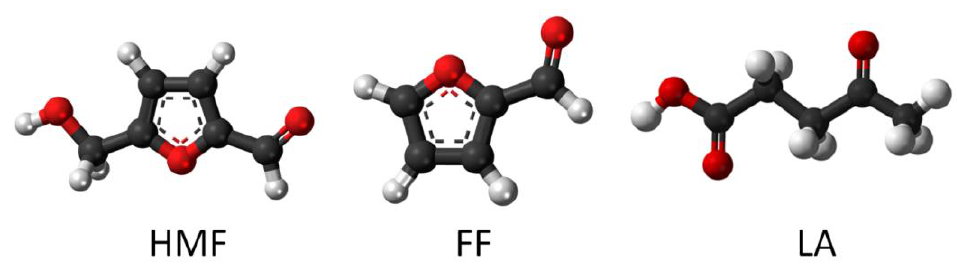
Figure 1. Chemical structures of fermentation inhibitors (HMF, FF, and LA). Red, white, and black colors represent the oxygen, hydrogen, and carbon atoms, respectively.